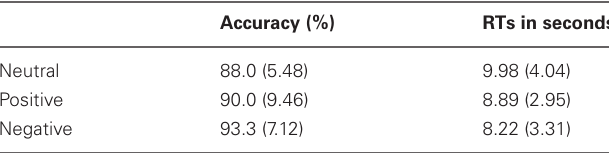
Table 4 | Mean accuracy and response times for the subtraction problems in Experiment